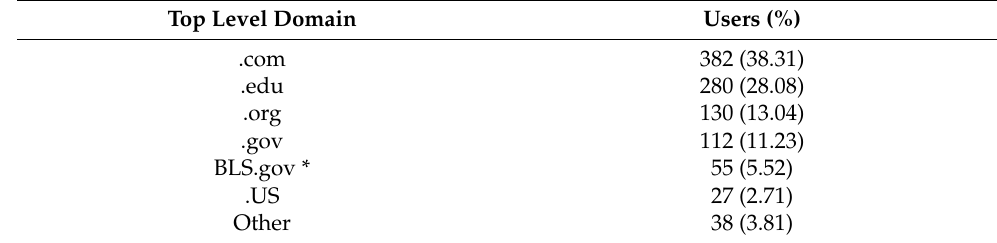
Table 4. User account email